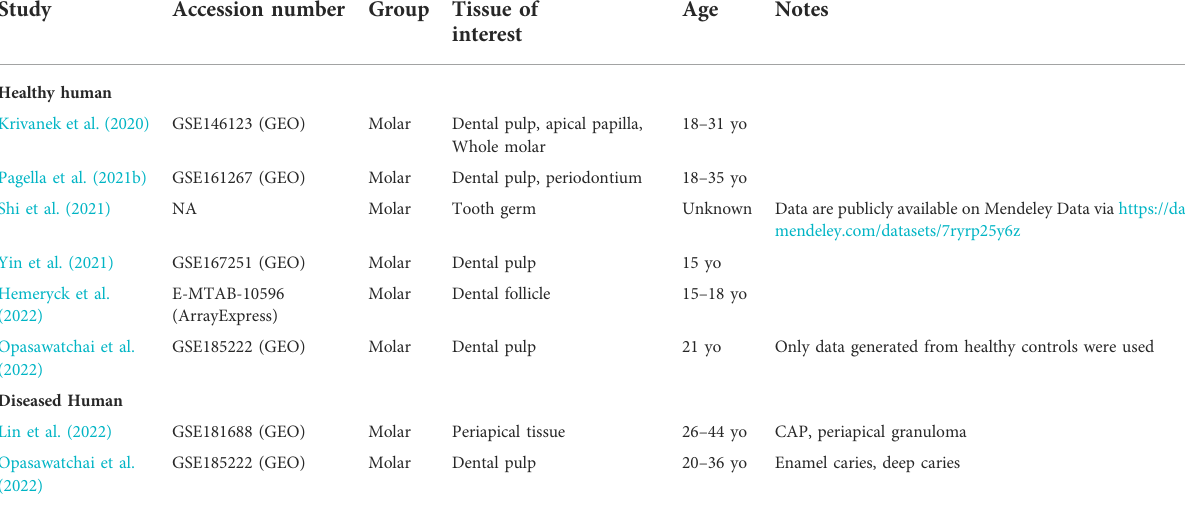
TABLE 4 Publicly available human scRNA-seq datasets re-analyzed and integrated toward the comprehensive human tooth atlas.